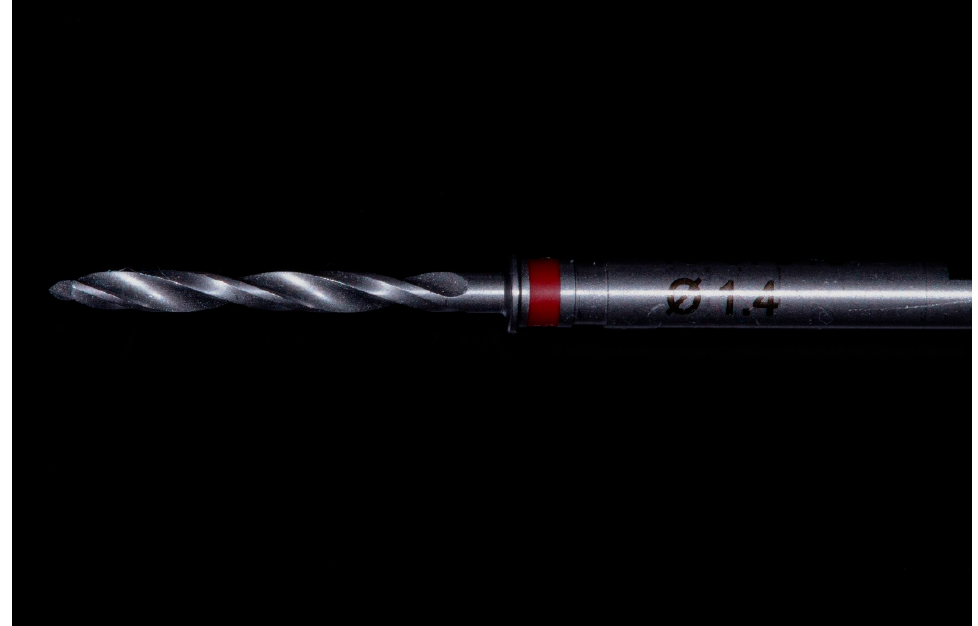
Figure 2. 1.4 mm diameter drill used for the investigation.